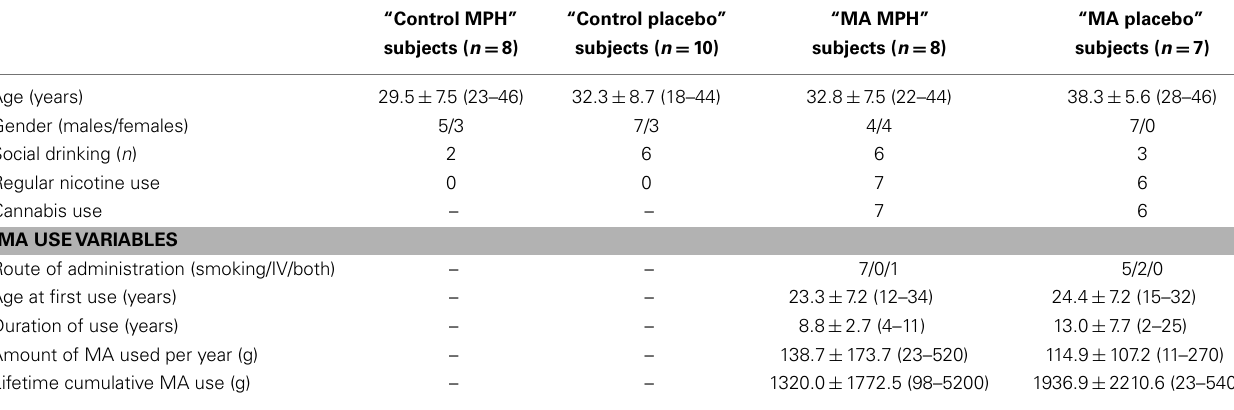
Table 1 | Mean ± standard deviation (range) for demographic characteristics of